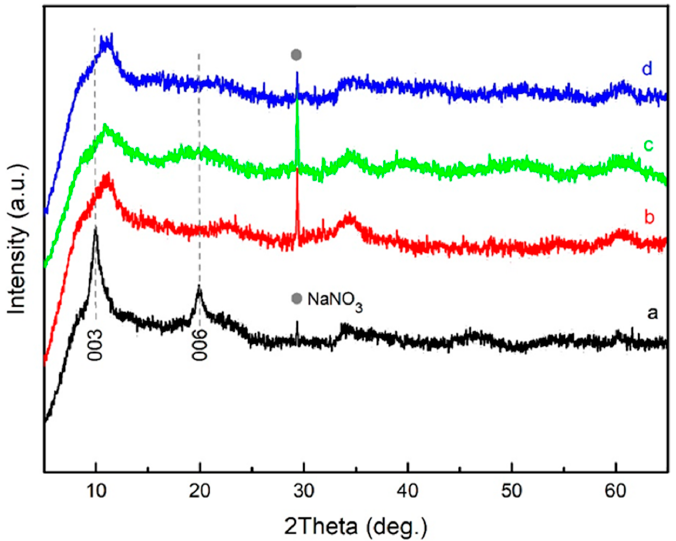
Figure 1. X-ray diffraction (XRD) patterns of the Co 2 Al–NO 3 layered double hydroxides (LDHs) synthesized using the conventional co-precipitation method ( a ) and by means of the ultrasonic treatment of the stoichiometric mixture of the respective metal nitrates at 1.5 kW for 3 min ( b ), 5 min ( c ), and 10 min ( d ) followed by 4-h thermal treatment in a water bath. The strongest peak of the residual sodium nitrate (from the parent solution) is indicated.